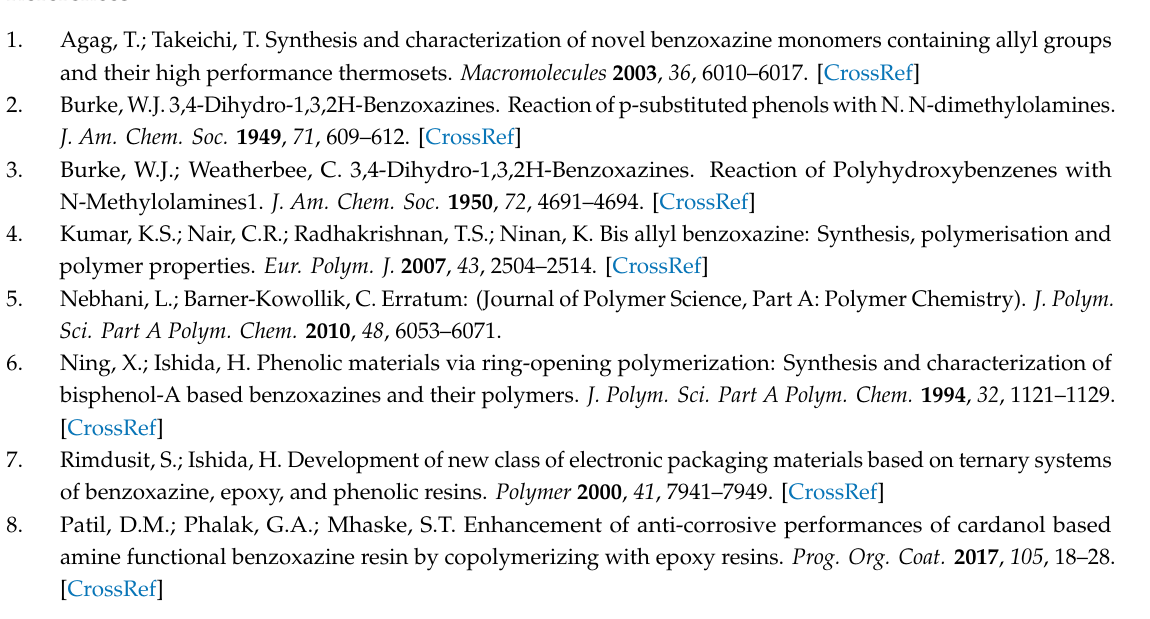
Figure S1: The DSC curves of benzoxazine at di ff erent heating rates. Figure S2: Tan δ curves of nanocomposites containing various SPOSS-BOZ contents. Figure S3: EDX analysis of the fracture surface of SPOSS-PBZ-E. Author Contributions: X.L. conceived and designed the experiments; B.L. and H.W. performed the experiments; B.L. and H.W. synthesized monomer and composites, B.L., H.W., R.Y., and X.G. analyzed the data; B.L. wrote the